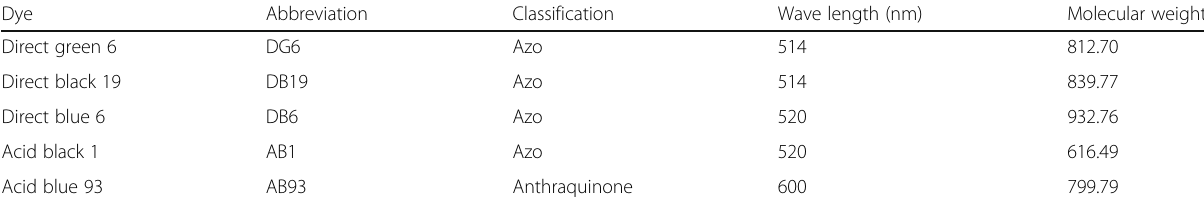
Table 1 Characteristics of dyes used in this